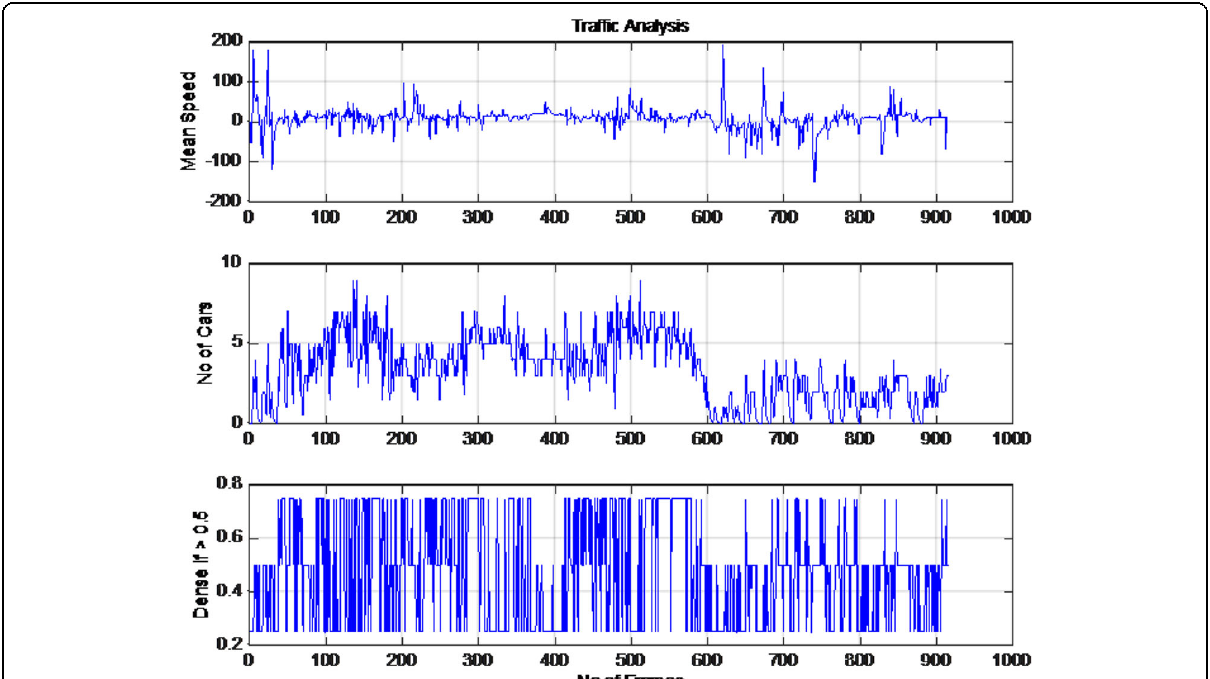
Fig. 8 Fuzzy logic-based traffic flow analysis of motorway